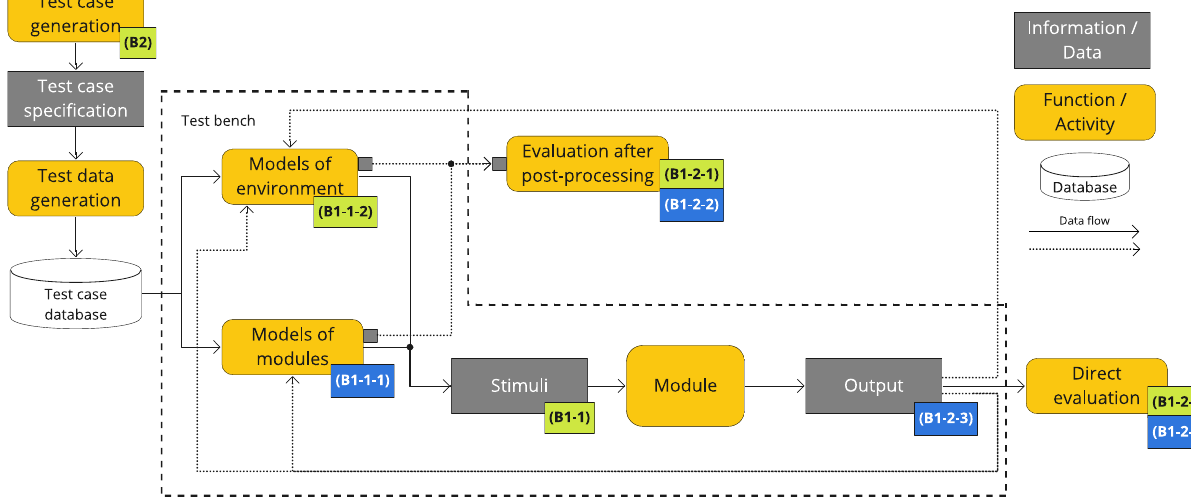
Figure 5. Generalized test bench of a module visualized as UML activity diagram including the steps towards test case identification and generation as well as the evaluation. The dashed line represents the test bench boundary. Dotted lines show feedback data for evaluation. Green boxes show the location of errors discovered by the fault tree analysis. Blue boxes show the location of errors found by the analysis of the test bench and the test procedure.